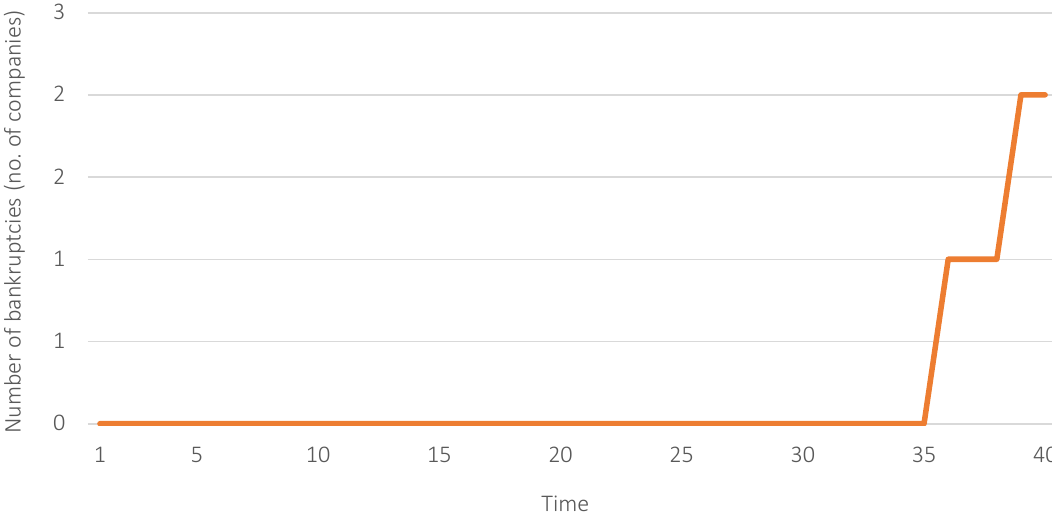
Figure 17. Evolution of the number of bankruptcies in Islamic LBO market (out of 500